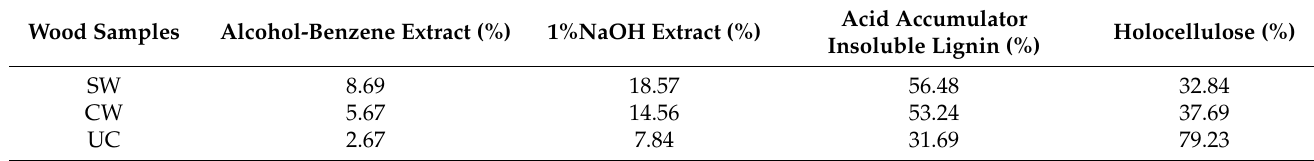
Table 1. Chemical composition of Luoyang No.1 ancient shipwreck